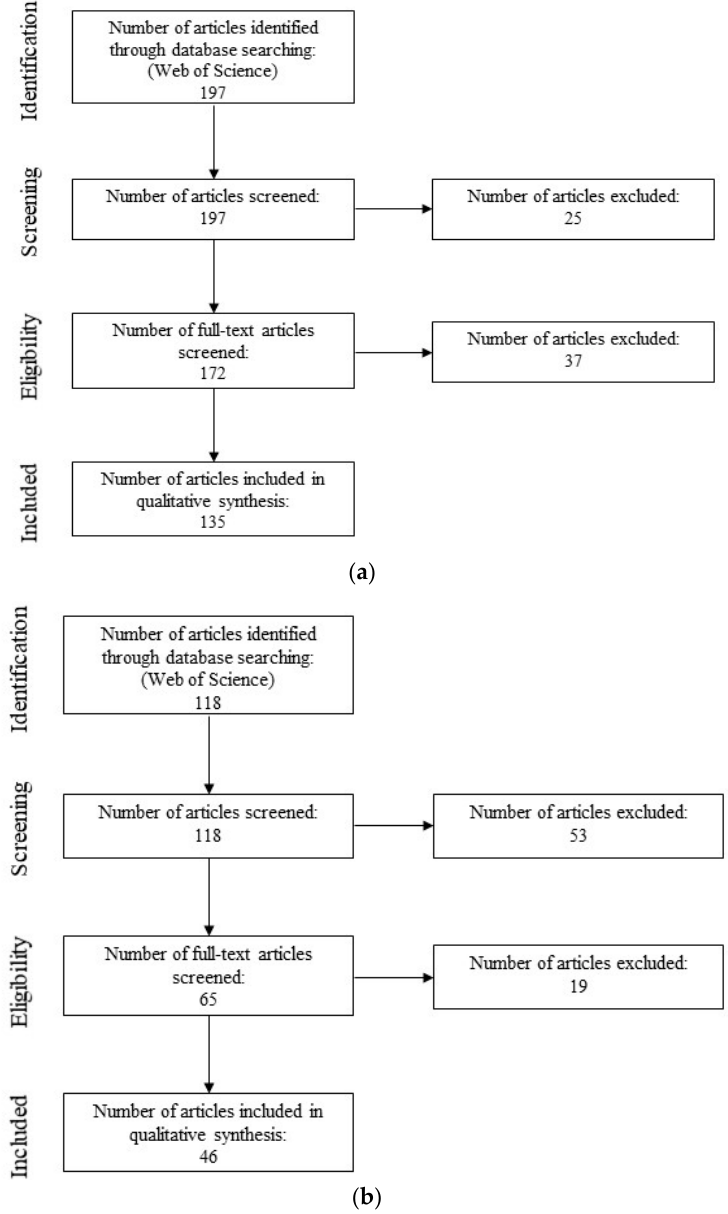
Figure 2. Flow chart of the selection process for articles via the semi-systematic review for Section 2.1 ( a ) and Section 2.2 ( b ), similar to Moher et al. [60].